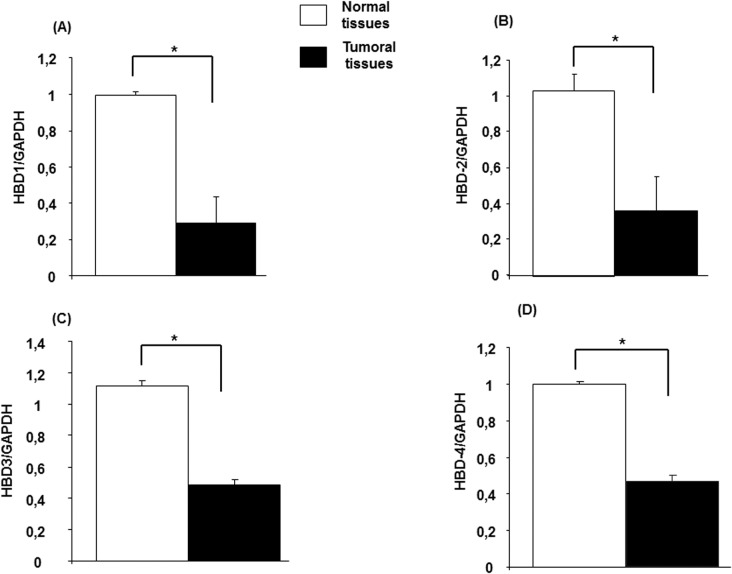
Human beta defensin (hBD) mRNA and protein expression in colon cancer tissues.Total cellular RNA freshly extracted from normal and colon cancer tissues was reverse transcribed into cDNA and then used to measure the hBD mRNA expression (Panel1A to 1D).